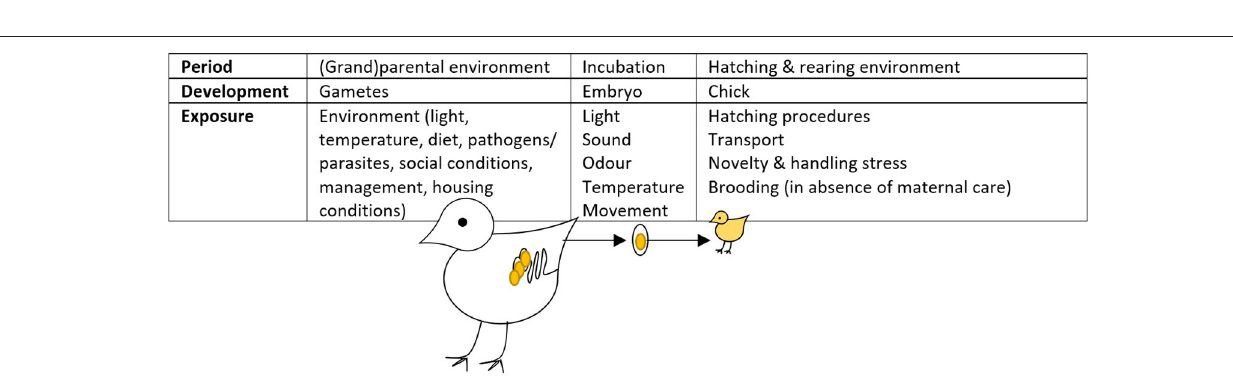
in the mother and, further, in the shelled egg where the embryo develops, and in early post-hatch life ( Figure 2